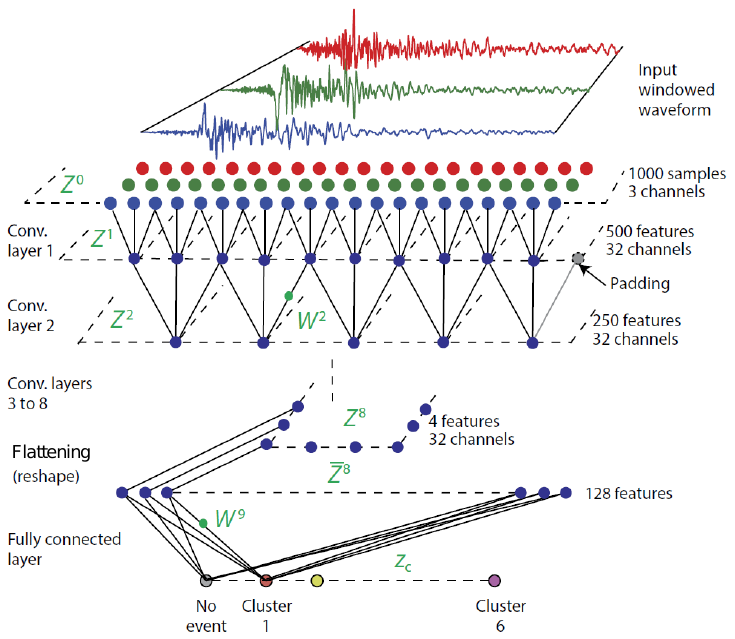
Figure 7. Network structure of ConvNetQuake model (from [80]).